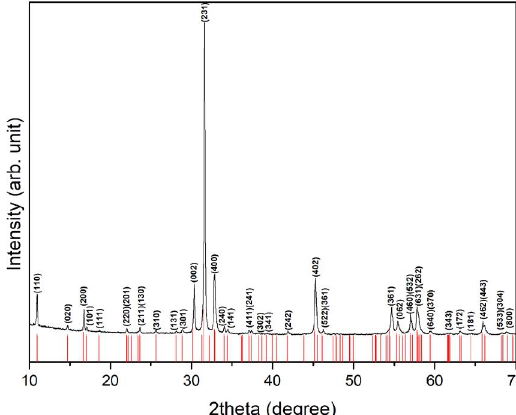
WO microcrystals 2 4